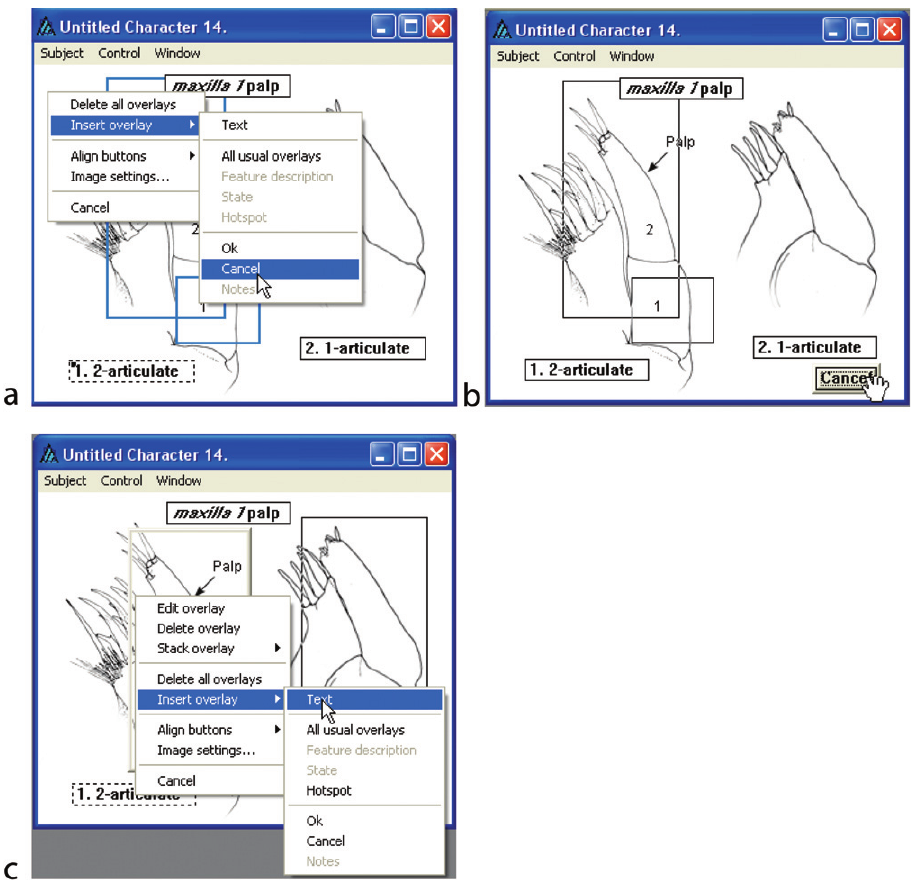
Figure 21. Inserting a Cancel button and additional text overlays on a character